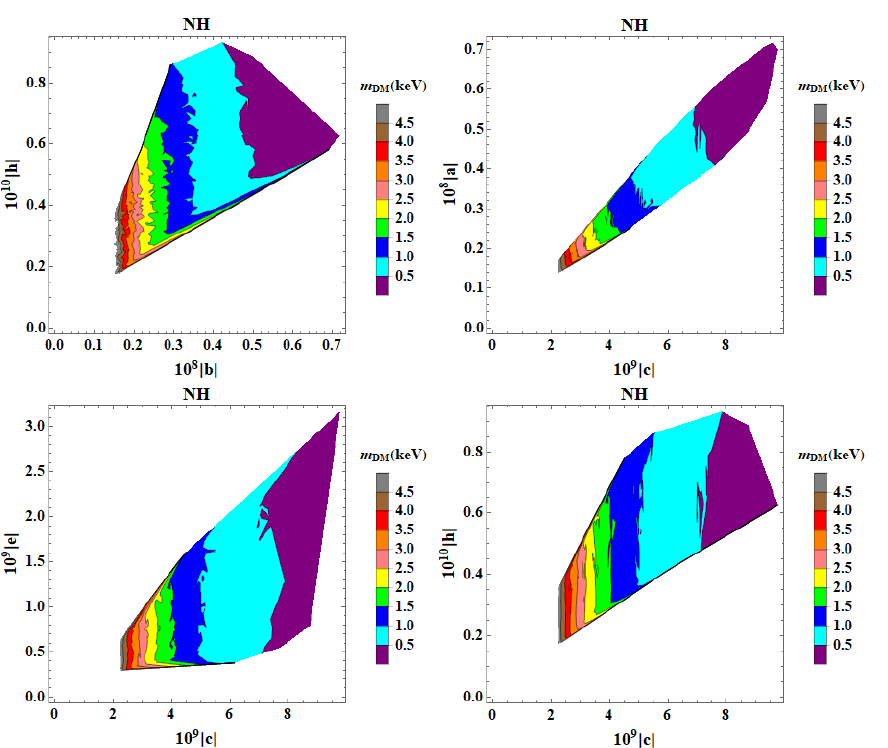
Figure 5 . Variation of di(cid:11)erent model parameters (in eV) with Dark Matter mass as a contour for normal hierarchy. The mass limit as predicted by cosmology is (0 : 4 (cid:0) 50)keV.